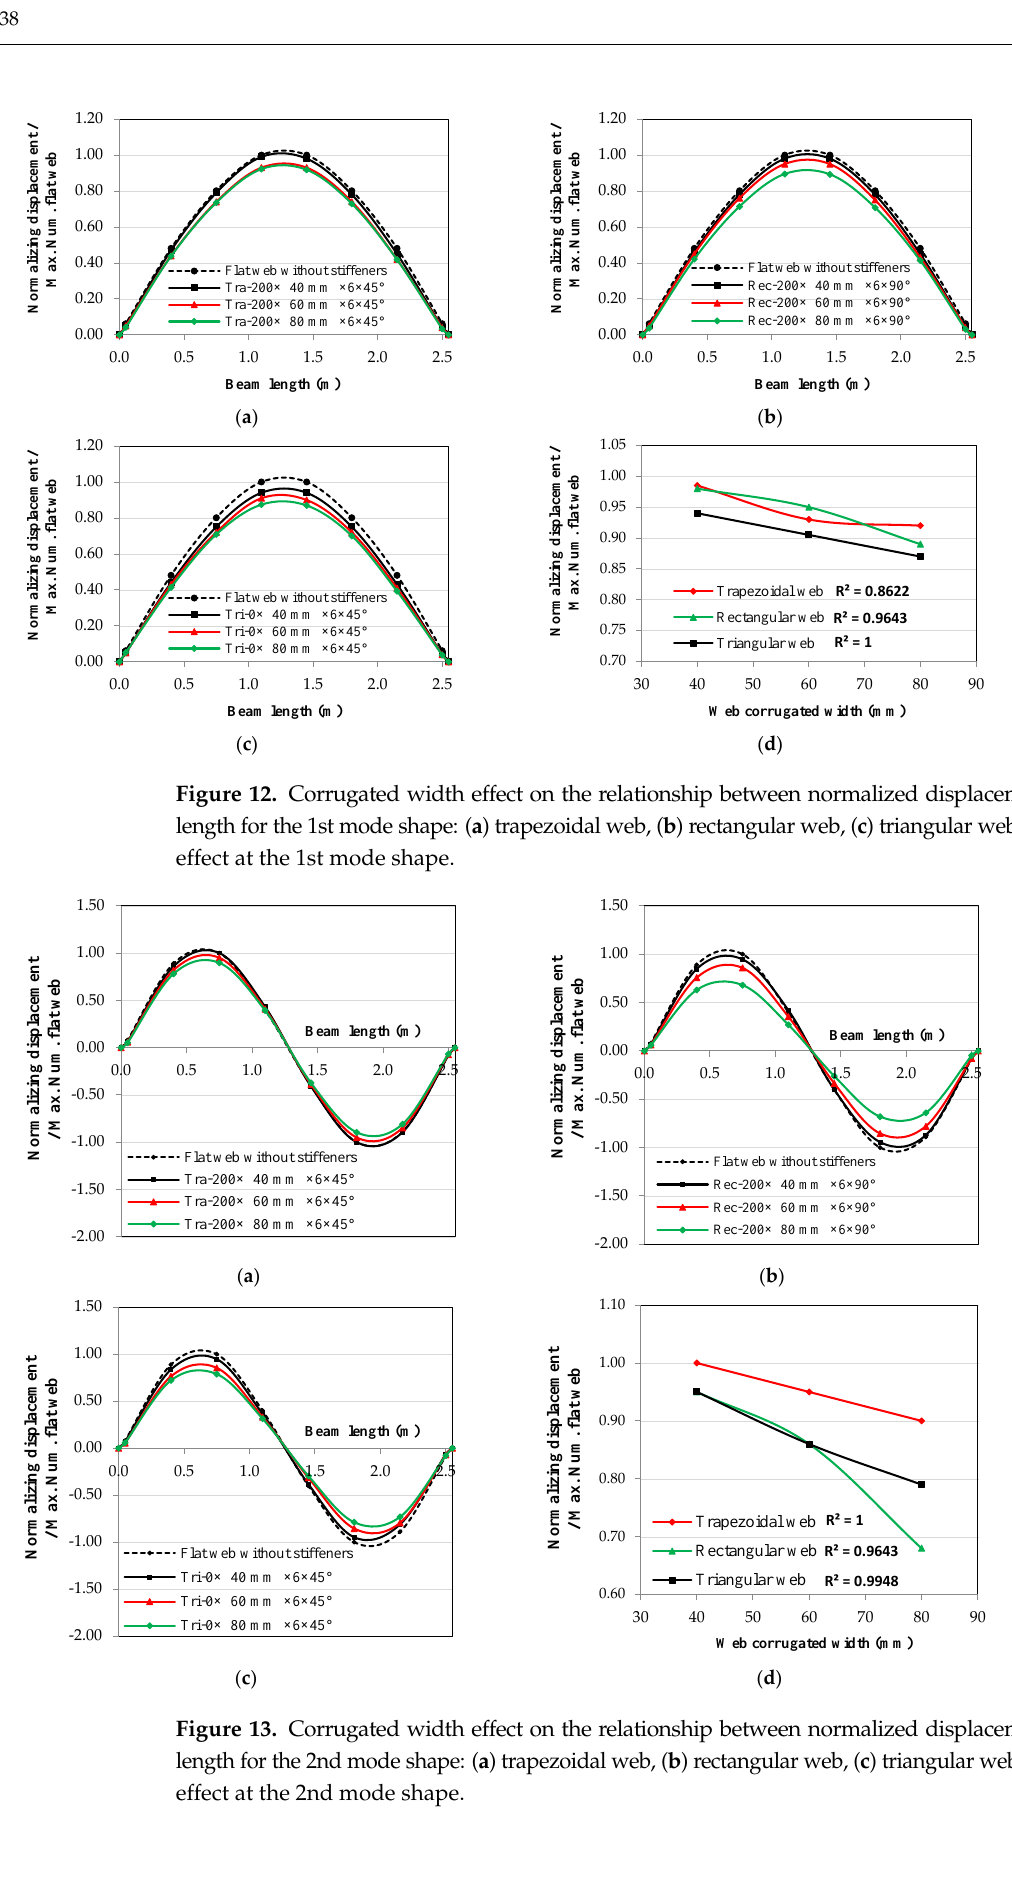
( d ) Figure 14. Corrugated width effect on the relationship between normalized displacement and beam length for the 3rd mode shape: ( a ) trapezoidal web, ( b ) rectangular web, ( c ) triangular web, and ( d ) width effect at the 3rd mode shape.